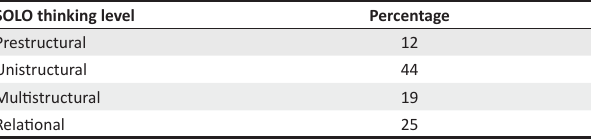
TABLE 2: Teachers’ statistical thinking levels for item number 4 (Family car task).